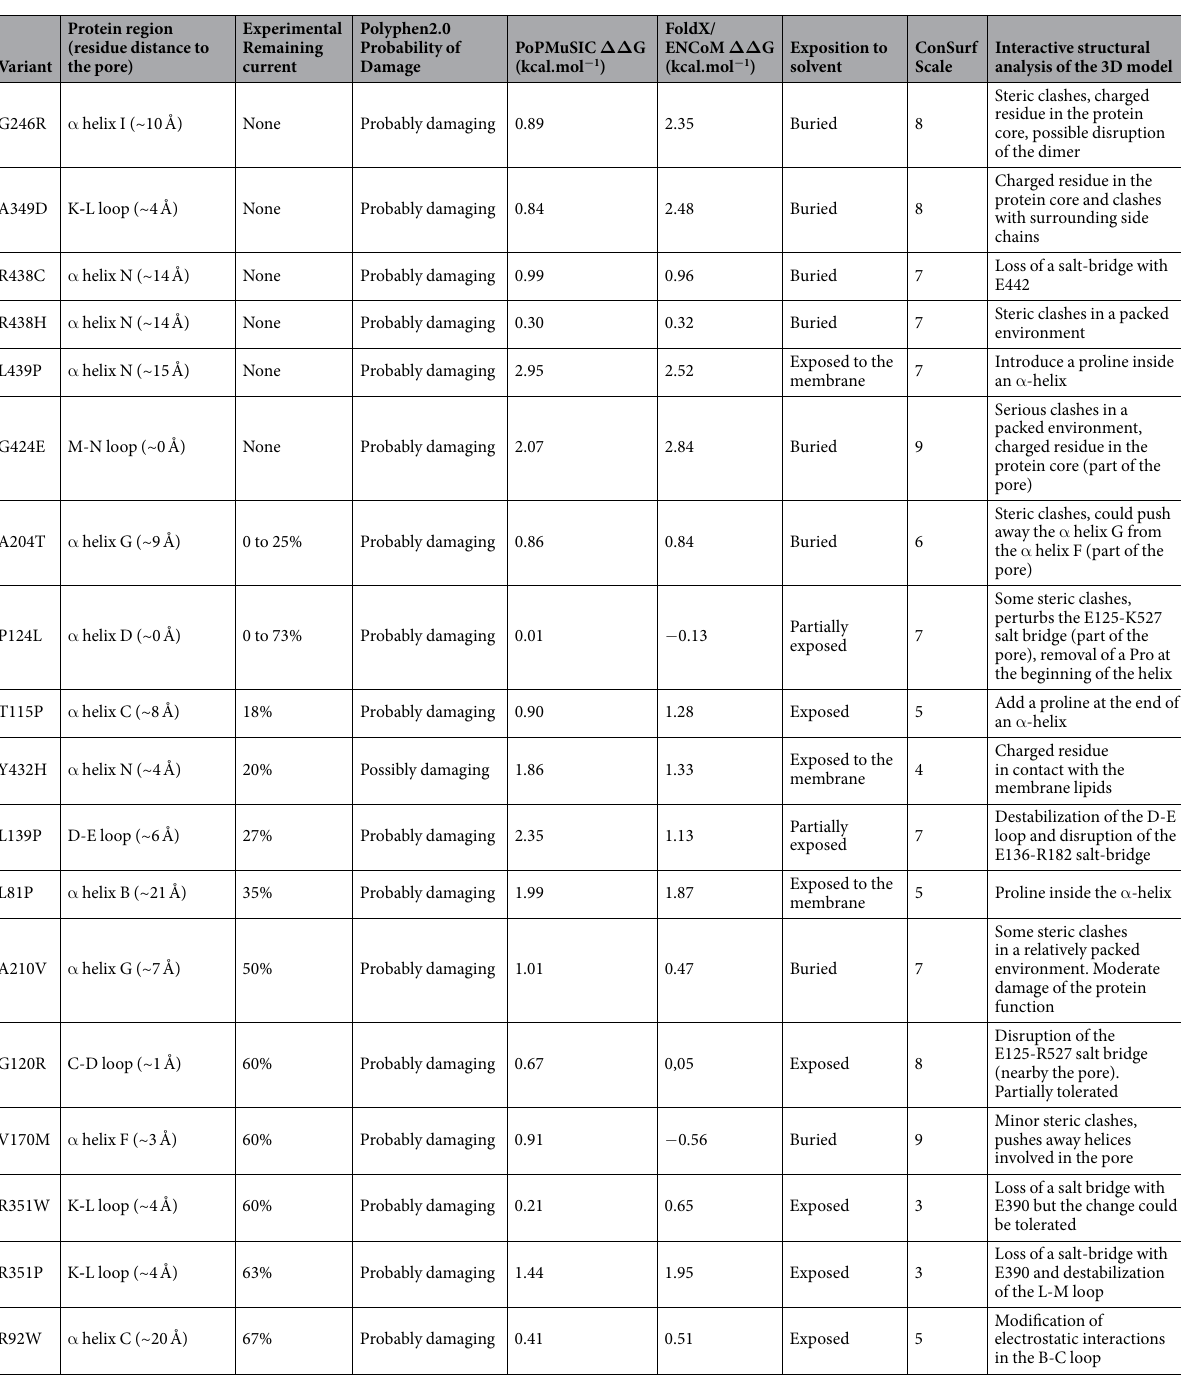
Table 1. ClC-Kb mutations involved in the Bartter syndrome type 3 with available experimental data. The mutations were sorted according to their current decrease. The investigated residues were: L81P 90 , R92W 90